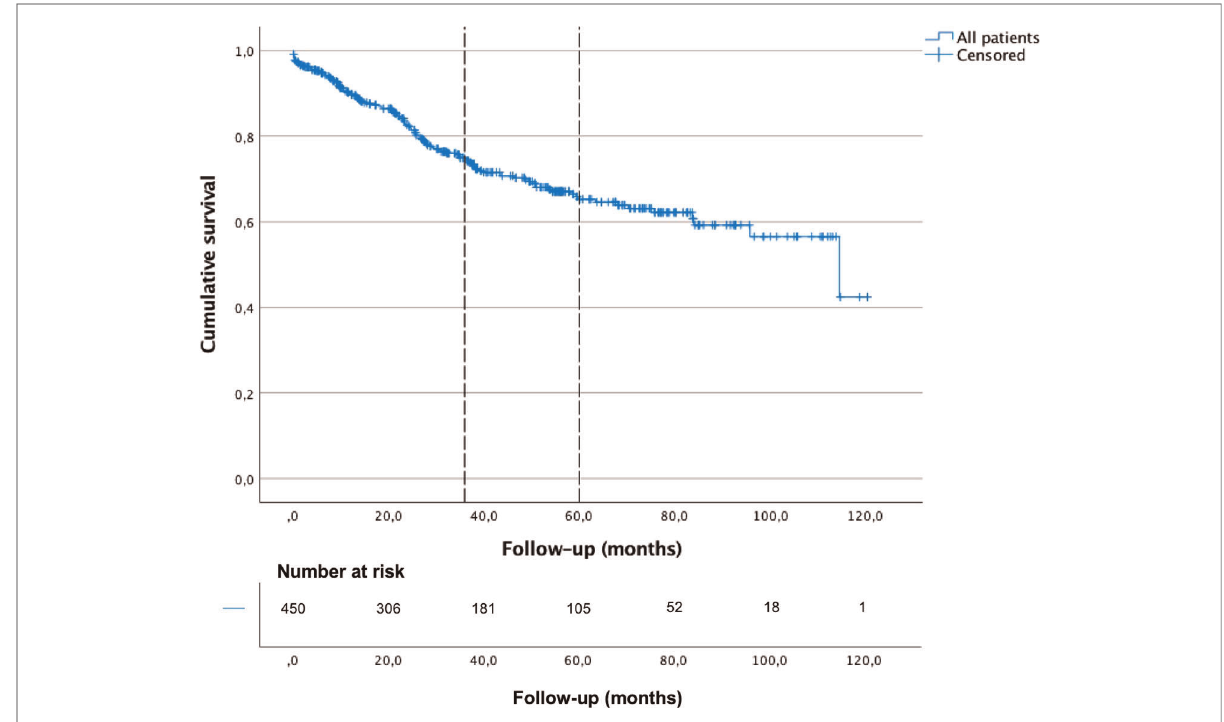
FIGURE 2 Overall survival of gastric cancer patients treated with curative intent, Kaplan-Meier curve.